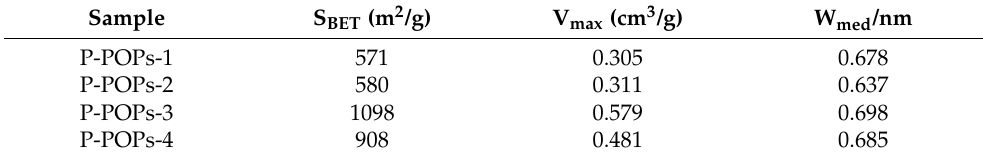
Table 1. Information on the surface areas, pore volumes, and median pore diameter of P-POPs.